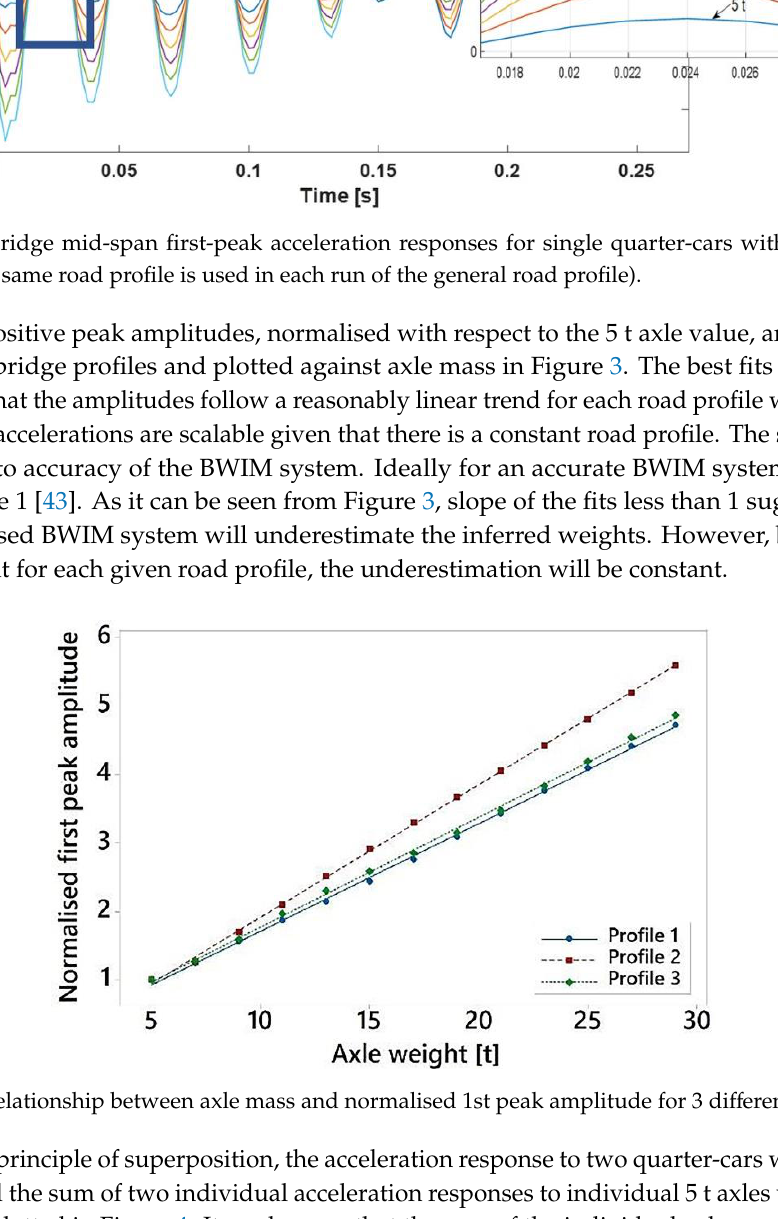
Figure 3. Relationship between axle mass and normalised 1st peak amplitude for 3 different profiles.